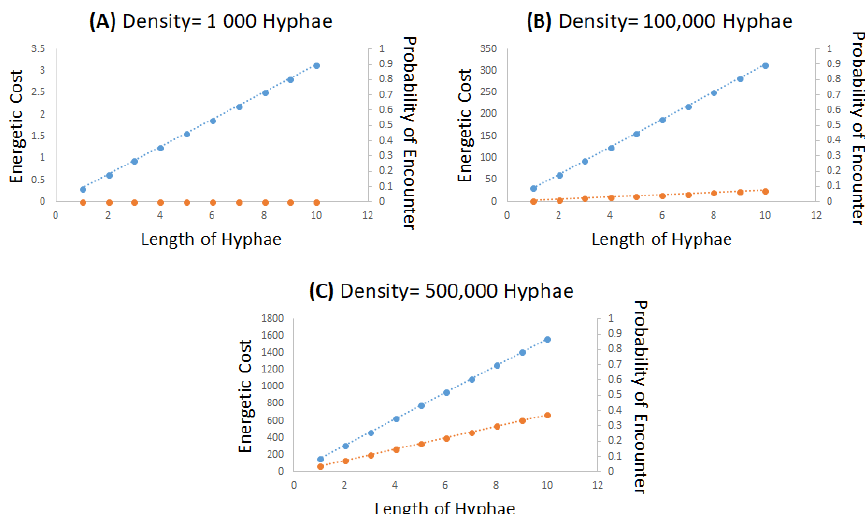
Figure 3. Three examples of a theoretic model relating to energetic cost of mycelial density to probability of an encounter of those mycelia with an insect or plant host. The model assumes that the cost is proportional to the total volume of the mycelia (blue line) while the probability of encounter assumes the volume of those hyphae relative to a sphere with a radius equal to the maximum length of a hypha (orange line). Shown are three examples where the mycelial density is ( A ) Low density (“sleeper”), ( B ) Medium density (mixed strategy), and ( C ) High density (“creeper”). Note that scales of the energetic cost in the three graphs are different and that there is a relatively lower metabolic cost associated with low density.